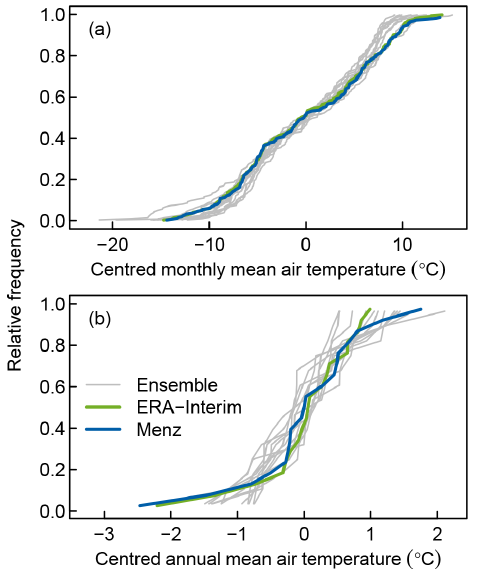
Figure 2. Cumulative distribution function of centred monthly (a) and annual mean air temperature (b) , based on data from 1991 to 2010. The grey lines show the 12 historical scenarios in the ensemble, the green line shows ERA-Interim reanalysis data, and the blue line shows the observed data from the Menz weather station. All data are for the closest pixel or weather station to